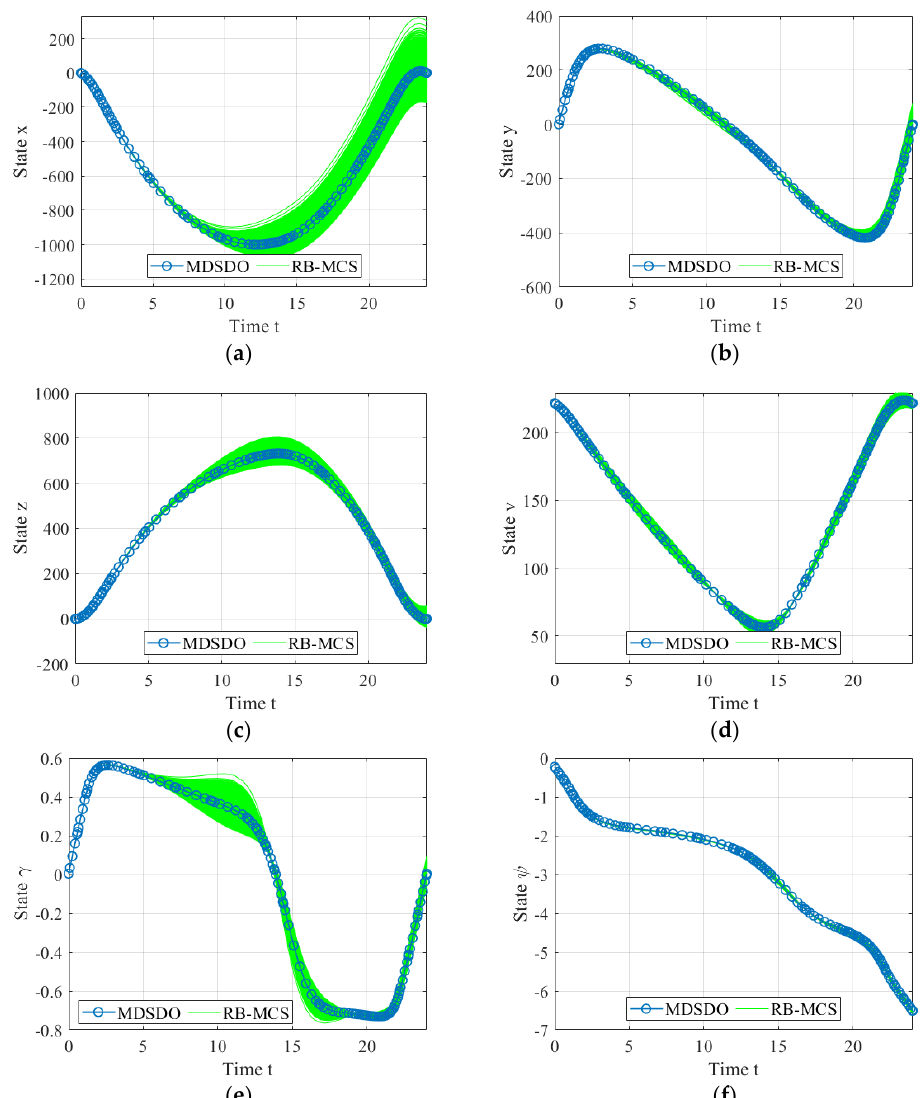
Figure 9. The uncertainty influence on state trajectories under MDSDO. ( a ) State trajectories of x . ( b ) State trajectories of y . ( c ) State trajectories of z . ( d ) State trajectories of v . ( e ) State trajectories of γ . ( f ) State trajectories of ψ